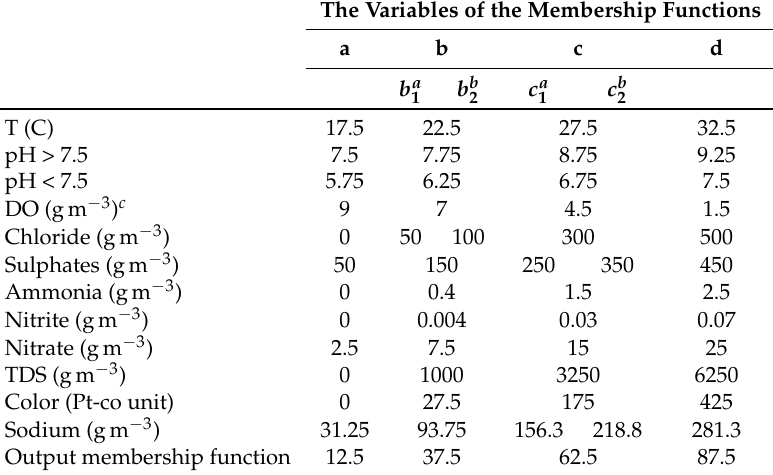
Table A10. The limits of the membership functions [52]. The Variables of the Membership